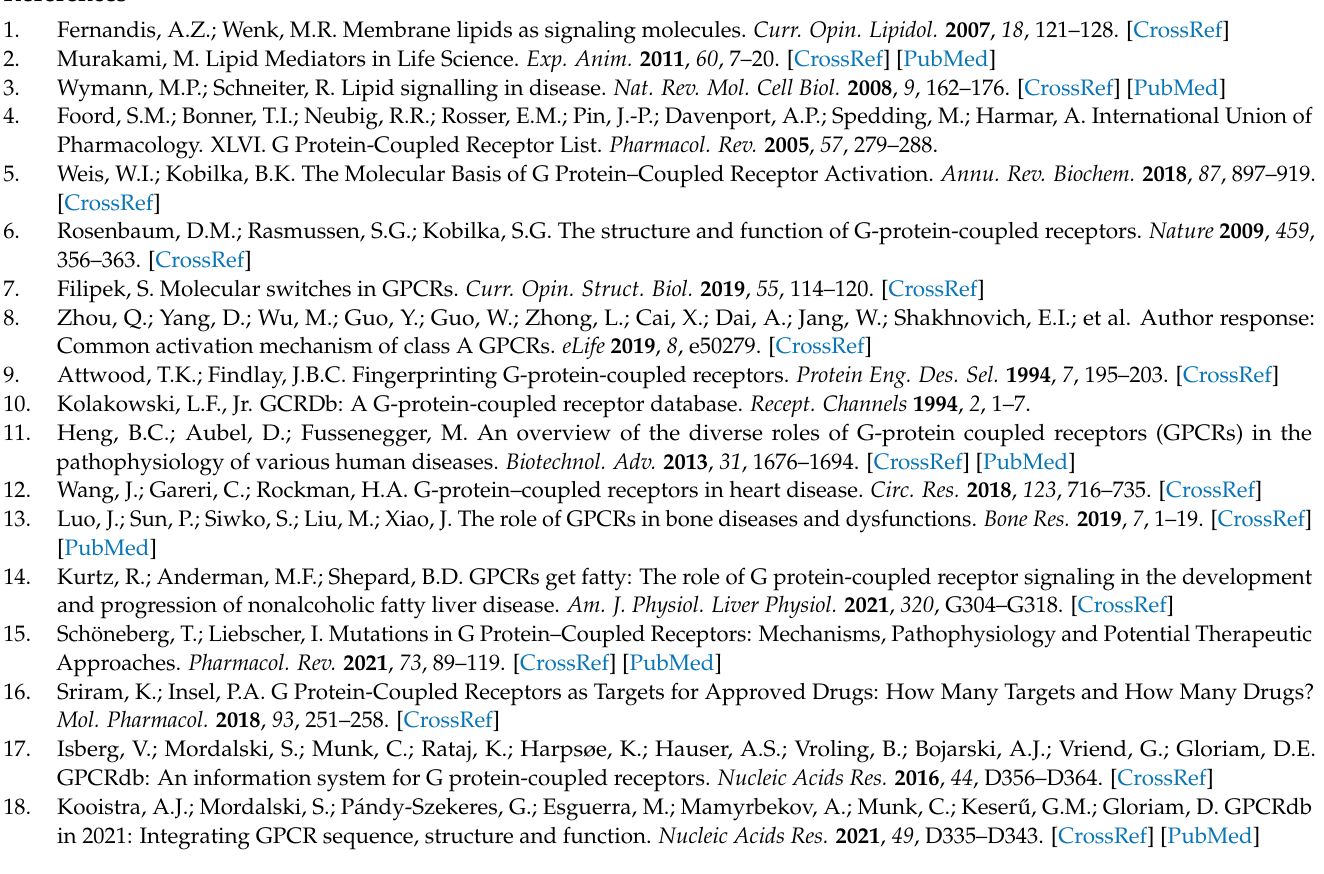
Table S2: Summary of disulfide bridges in lipid GPCR structures, Table S3: GPCR crystal structures co-crystallized with antibody/nanobody bound to intracellular epitopes, Table S4: GPCR crystal structures co-crystallized with antibodies bound to extracellular epitopes, Table S5: Therapeutic antibodies that modulate class A GPCR functions. Table S6: Class A GPCR antibodies that harness effector functions to achieve therapeutic effects